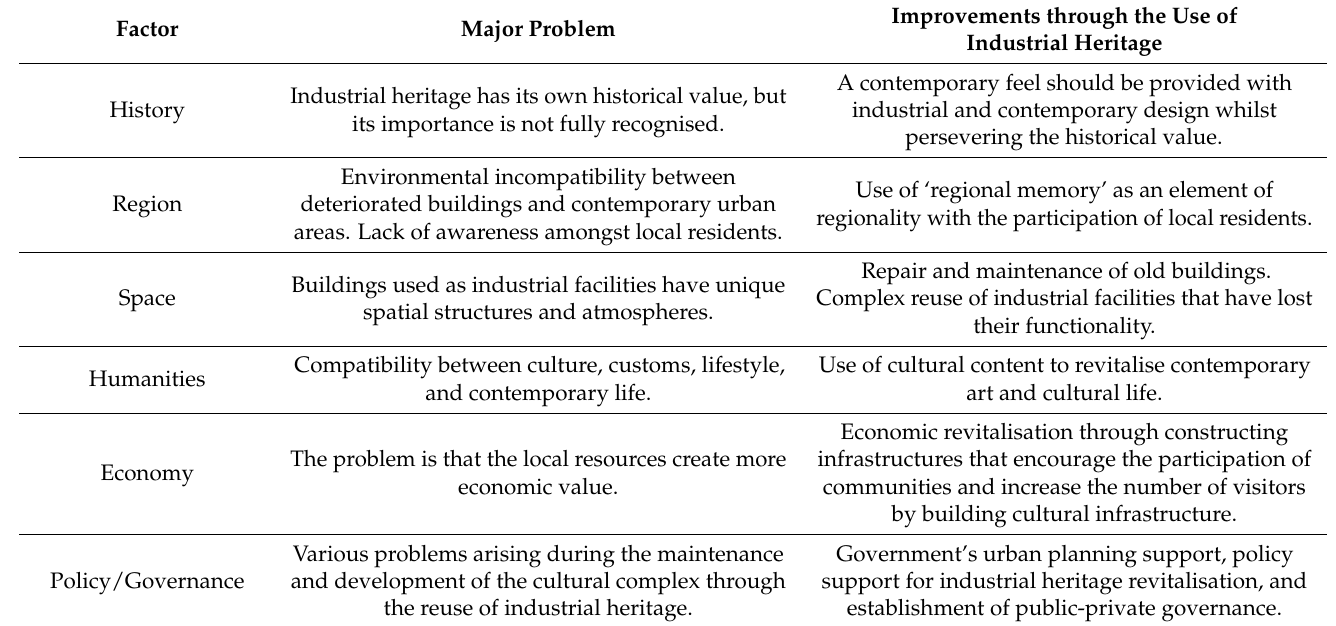
Table 1. Factor analysis for urban regeneration strategies utilizing industrial heritage